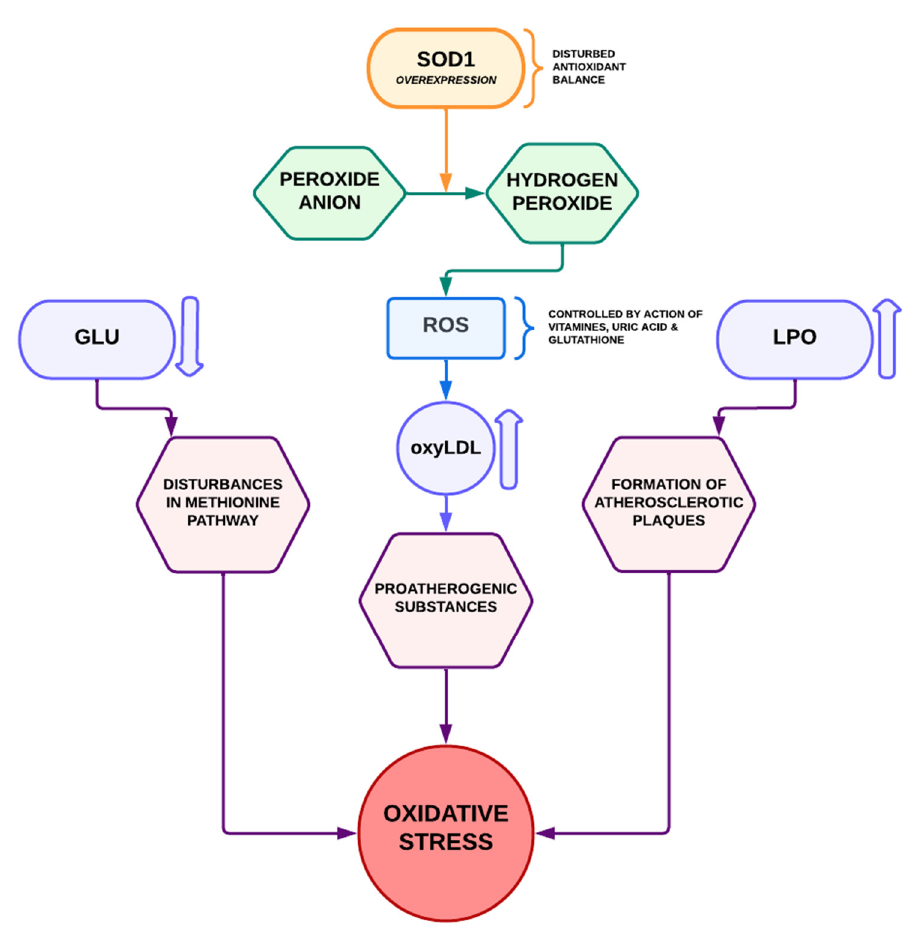
Figure 1. Oxidative stress processes in people with Down syndrome. SOD1-Superoxide dismutase; GLU-glutathione; ROS-reactive oxygen species; LPO-lipid peroxidation; oxyLDL-oxidatively modified LDLs.